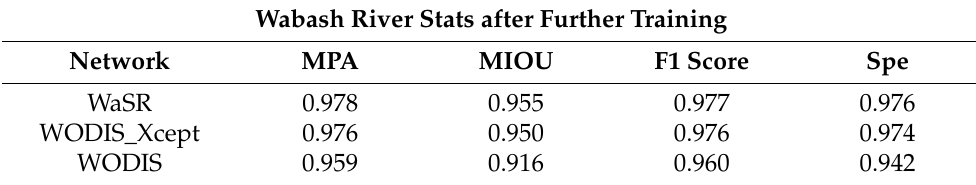
Table 4. Quantitative capability of networks on segmenting the Wabash River subset of ROSEBUD after training on the Sugar Creek subset for the number of epochs as summarized in Table 2.